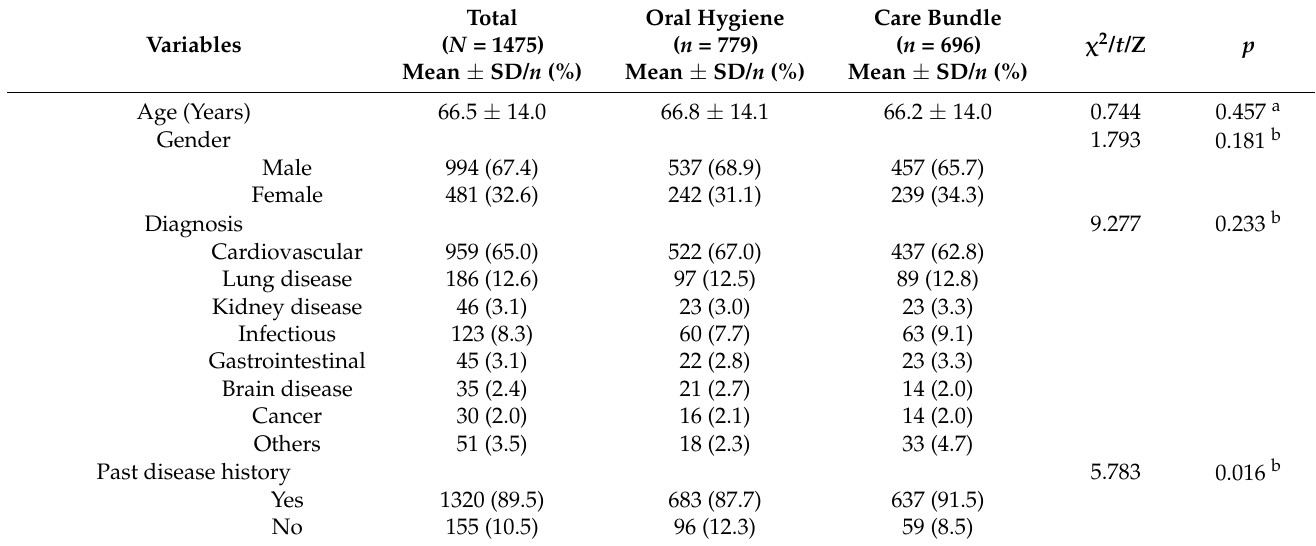
Table 1. Personal Characteristics of Study Participants ( N =